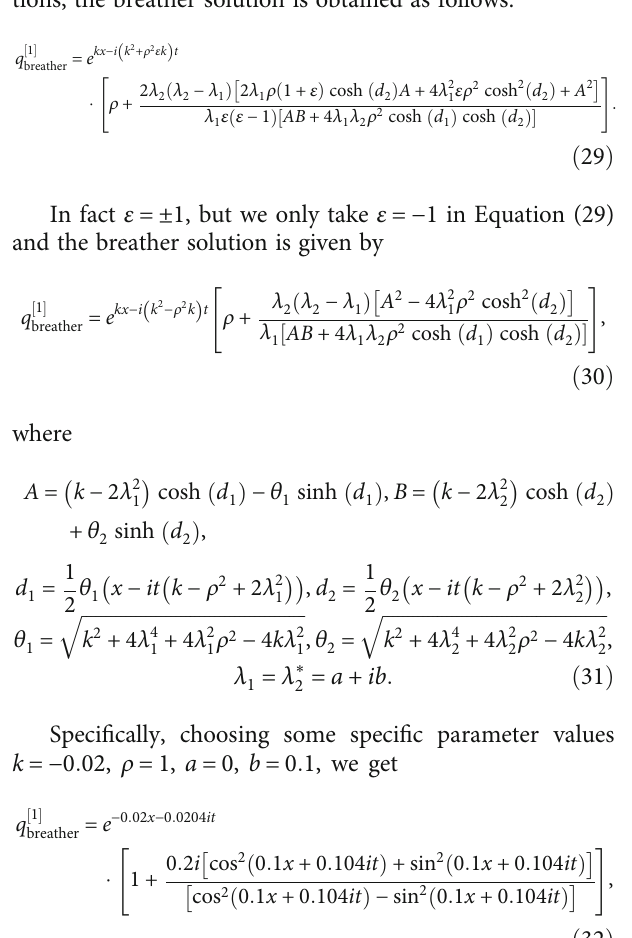
Figure 4: The fi rst-order rogue wave for ∣ q ½ 1 (cid:2) pro fi les at di ff erent times t = − 0 : 5 (red), t = 0 (blue), and t = 1